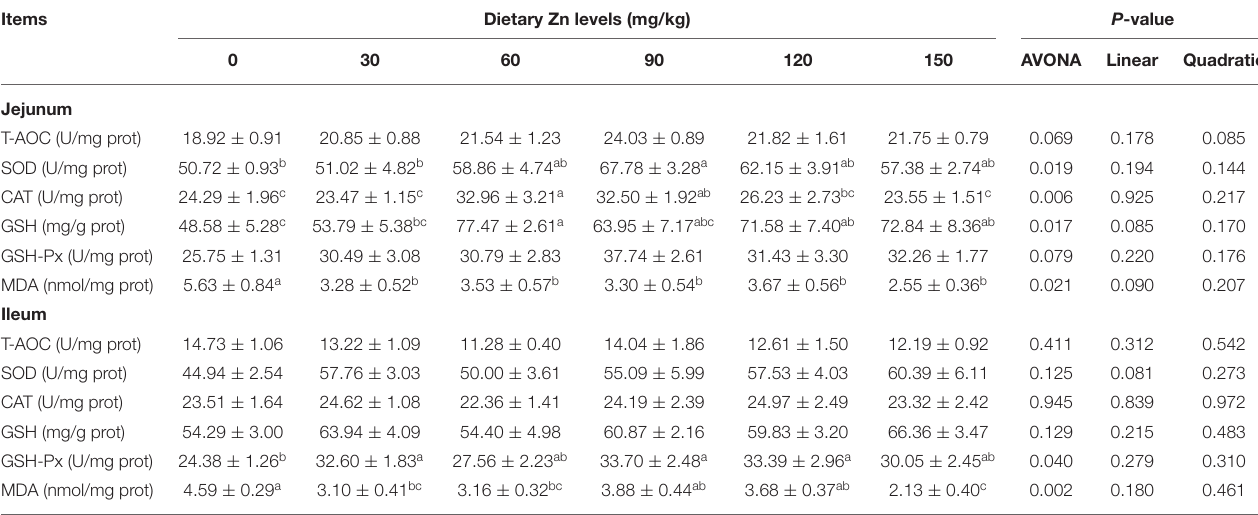
TABLE 5 | Effect of dietary Zn-Met on the antioxidant status in the intestine of ducks. Items Dietary Zn levels (mg/kg) P -value 0 30 60 90 120 150 AVONA Linear Quadratic